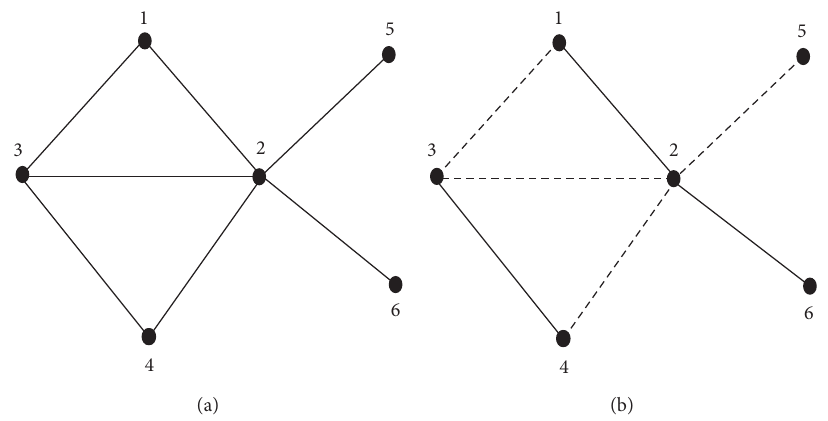
Figure 1: (a) Given network. (b) Its signed